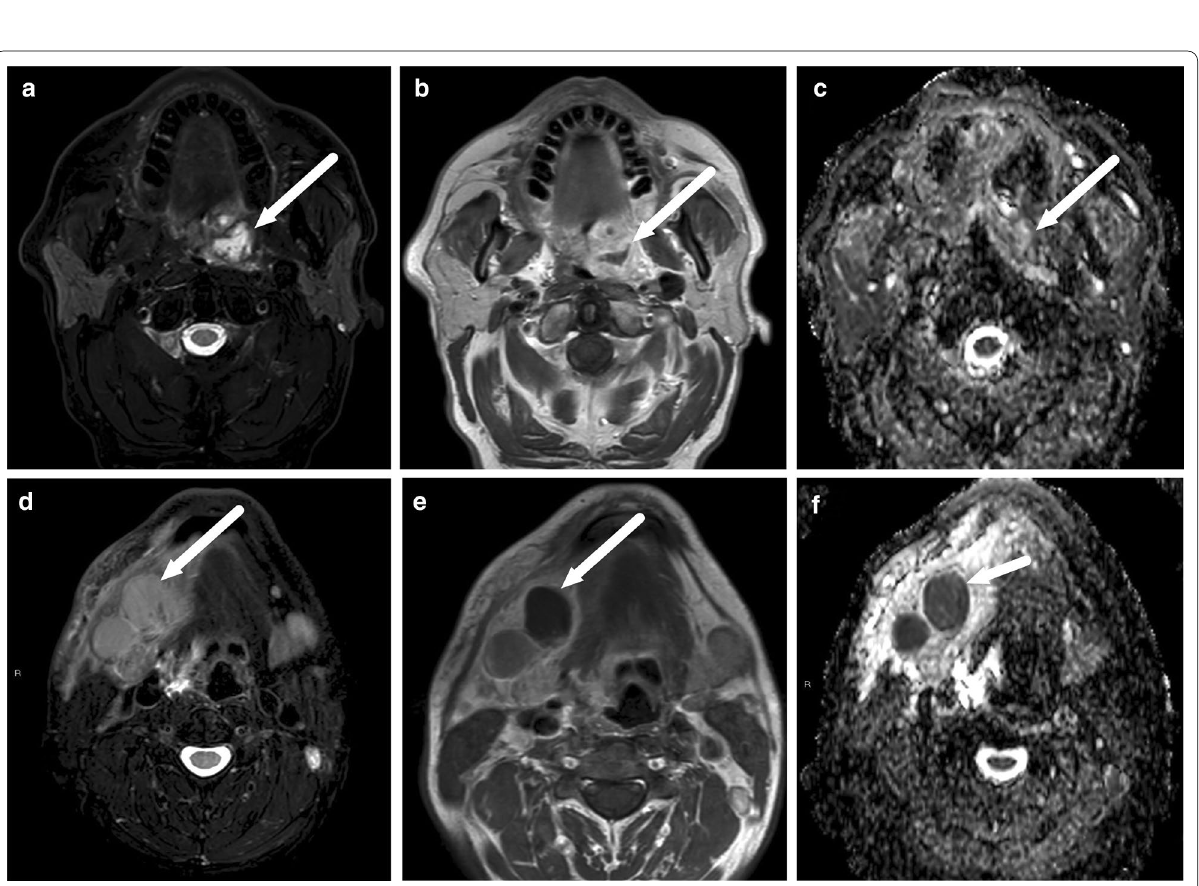
Fig. 6 False negative ( a – c ) and false positive ( d – f ) abscesses on axial fat-suppressed T2-weighted images ( a , d ), post-contrast T1-weighted images ( b , e ), and ADC maps ( c, f ) (arrows). False negative, top row ( a – c ): in a patient with a sore throat, a T2-hyperintense non-enhancing collection with ADC values were interpreted as high rather than low (no purulence). However, surgery found an abscess. False positive, bottom row ( d – f ): in a patient with neck swelling, MRI shows lymphadenitis and one enlarged submandibular lymph node with no enhancement and low ADC, and suppurative lymphadenitis (intranodal abscess) was diagnosed. However, surgery demonstrated necrosis but no purulence. Image modified from ref.